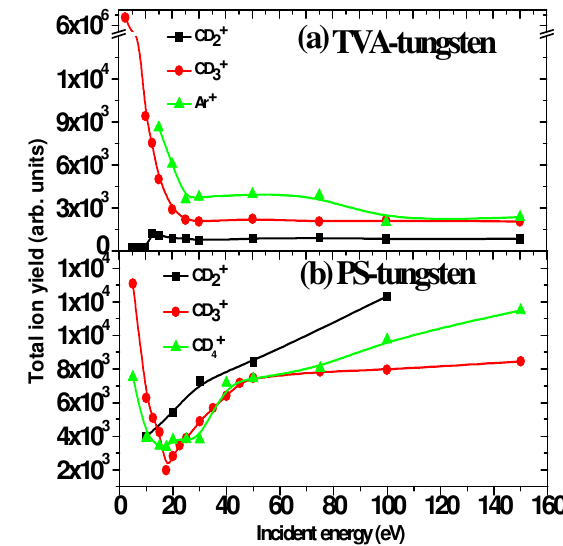
FIGURE 4: TOTAL ION YIELDS OF IONS AGAINST INCIDENT ENERGY FOR CD X+ AND AR + AFTER IMPACT WITH TUNGSTEN THIN FILMS.